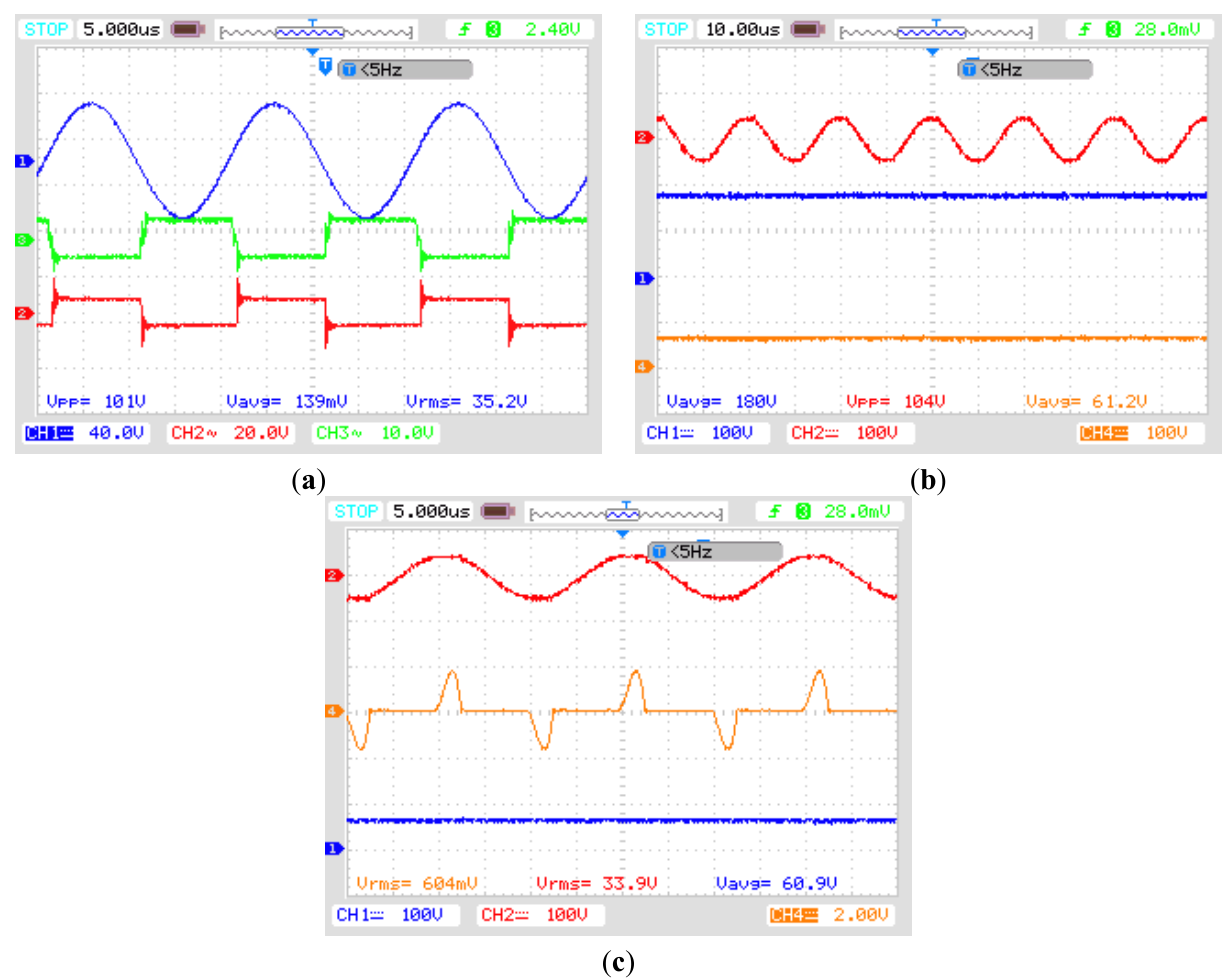
Figure 10. The waveform of switched signal, input and output voltage, input current (load resistance is 200 Ω ): ( a ) Ch1: input voltage (40 V/div); Ch2: switched signal S 1 (20 V/div); Ch3: switched signal S 2 (10 V/div); ( b ) Ch1: stepped up voltage V o1 (100 V/div); Ch2: input voltage (100 V/div); Ch4: output voltage (100 V/div); and ( c ) Ch1: output voltage (100 V/div); Ch2: input voltage (100 V/div); Ch4: input current (2